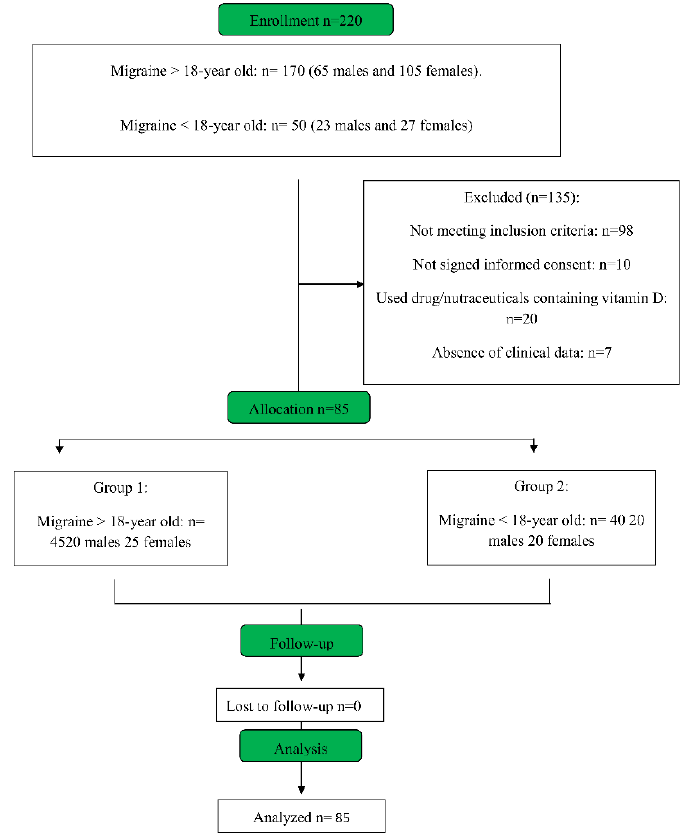
Figure 1. Consort diagram of migraine patients enrolled in this study.